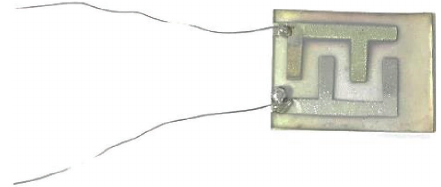
Figure 1: The fabricated PANI-Ag-Fe thin film sensor